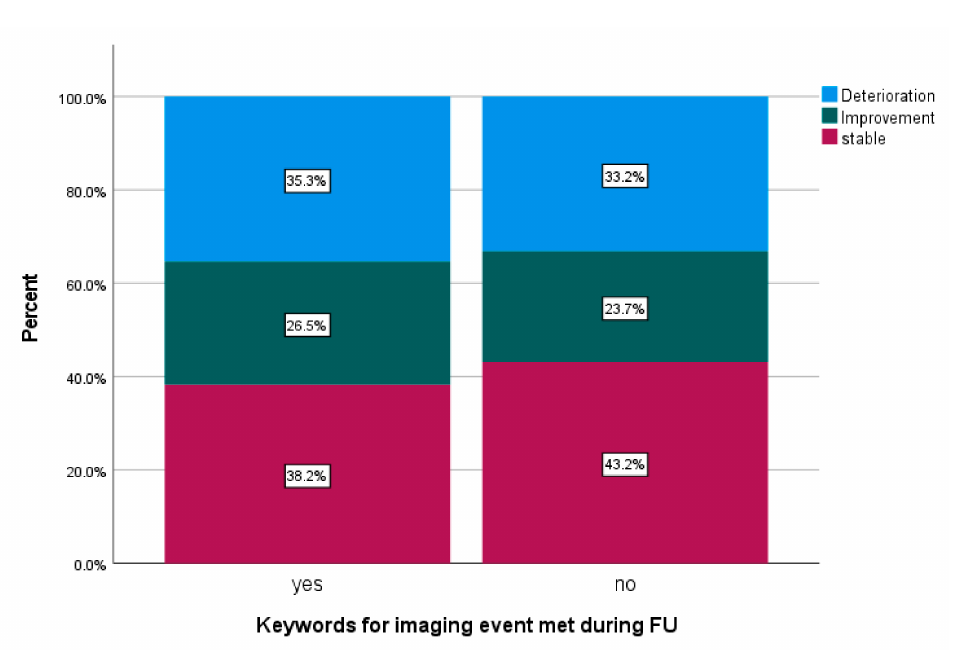
Figure 8. Changes in maximal adverse events of the CNS according to CTCAE Version 4.0 three years after PBT comparing patients with or without imaging events according to predefined